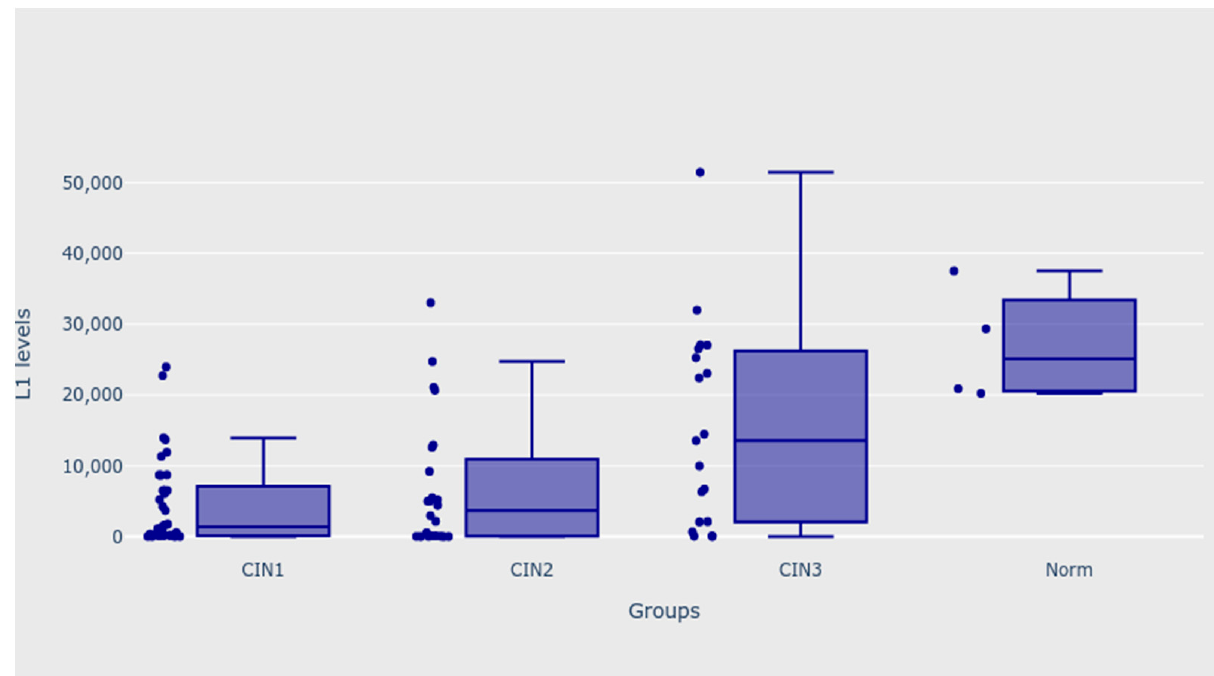
Figure 2. Levels of E4 protein—CIN 1, CIN 2, and CIN 3 groups.